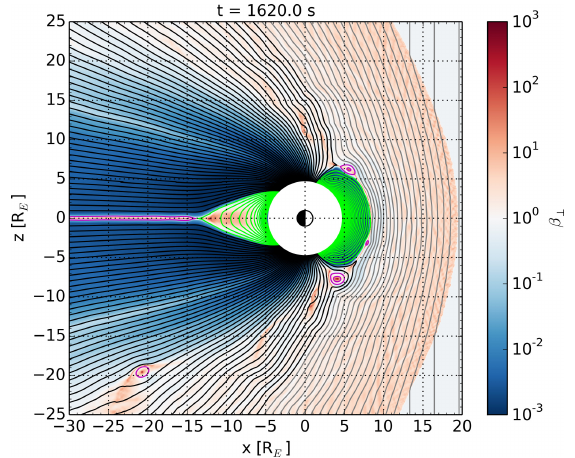
Figure 1. Snapshot from Animation S1 in the Supplement at 1620.0s (27:00). S1 illustrates the development of proton β ⊥ (ratio of thermal pressure perpendicular to the magnetic field and mag- netic pressure) and magnetic field lines in the x – z plane at 5s res- olution (reduced from 0.5s due to file size limitations) between 1400.0s (23:20) and 2150.0s (35:50). Closed field lines are drawn in green, open field lines in black, and IMF field lines in gray. Field lines that are closed but not attached to the geomagnetic field are drawn in magenta.